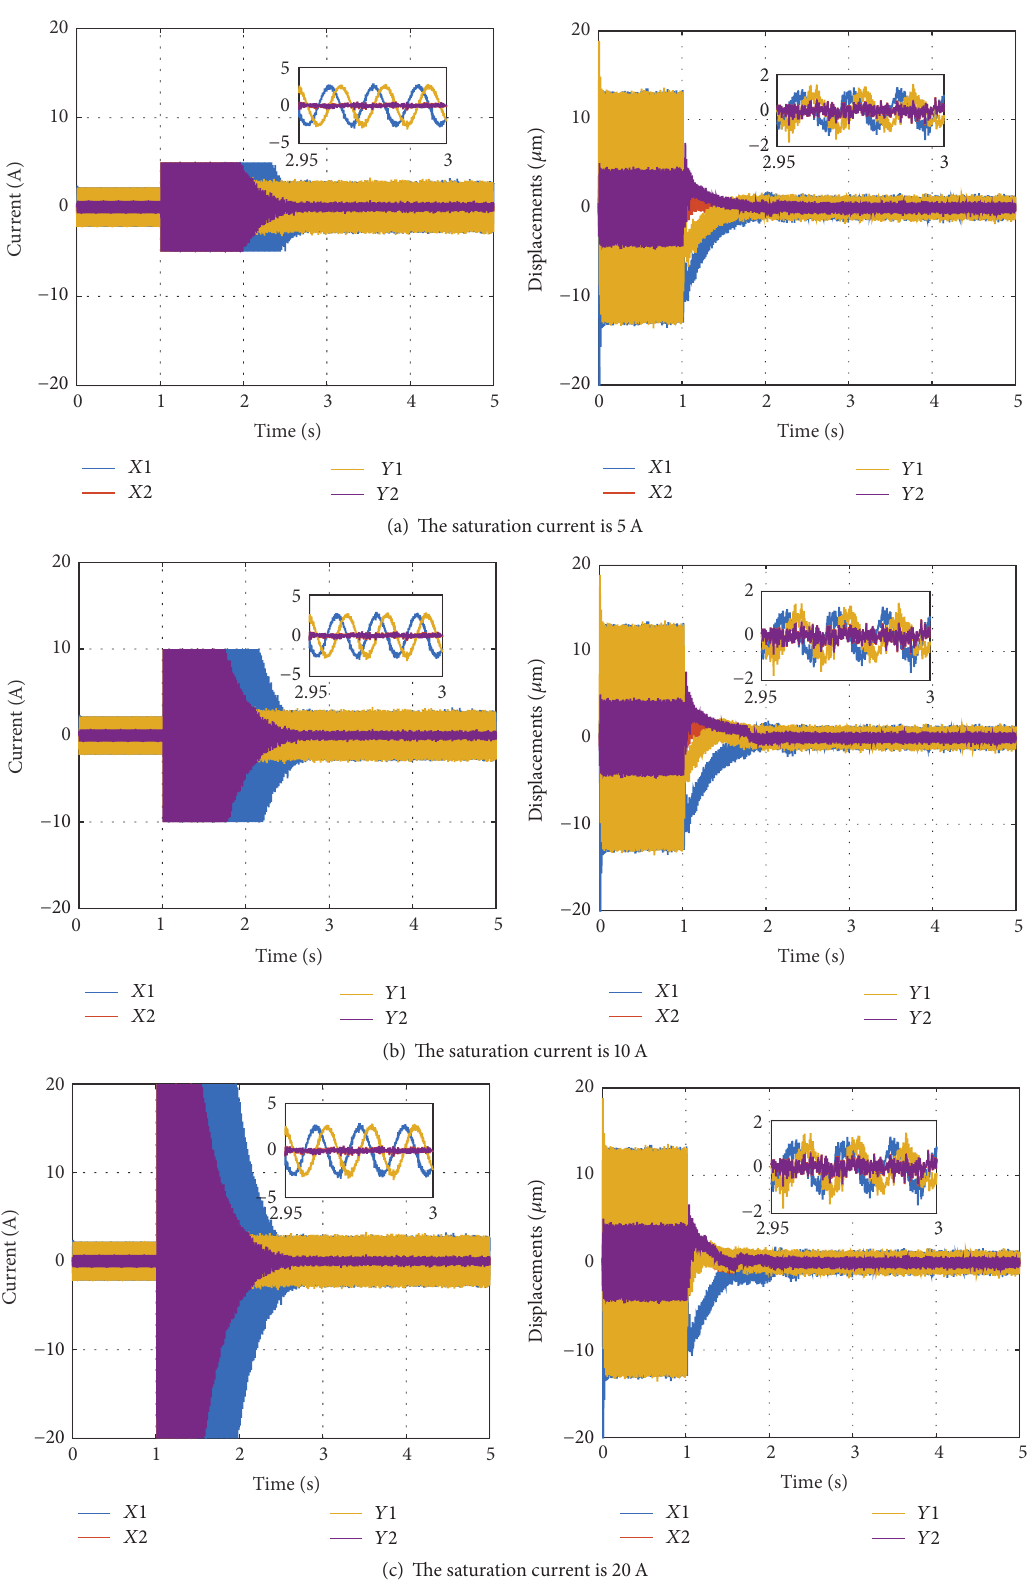
Figure17:Controlcurrentsandrotordisplacementsinradialdirectionswithdifferentpoweramplifiersaturationcurrents:therotoroperation speed is 4000